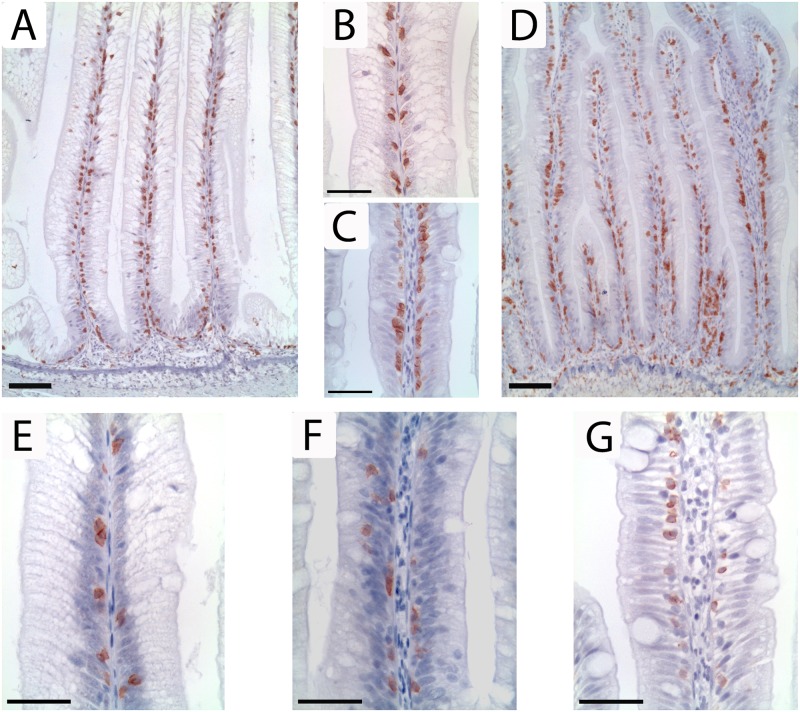
Immunohistochemical staining for CD3ɛ and CD8α positive cells at day 30.Immunohistochemical labelling (brown) showed an abundant presence of CD3ɛ positive cells at the base of the epithelium along the entire length of simple folds in all diet groups (A: FM200CU; D: SBM). At higher magnification, CD3ɛ positive cells were rarely present in the lamina propria of the simple folds in any of the diets (B: FM200CU; C: SBM). However, there was a higher number of CD3ɛ positive cells in the lamina propria adjacent to the stratum compactum in groups fed diets with SBM (D: SBM). CD8α positive cells were mainly found between the epithelial cells of all individuals of all diet groups (E: FM200CU; F: SBM200CU; G: SBM). Image A and D captured at 10x magnification, Image B, C, E, F and G captured at 40x magnification.